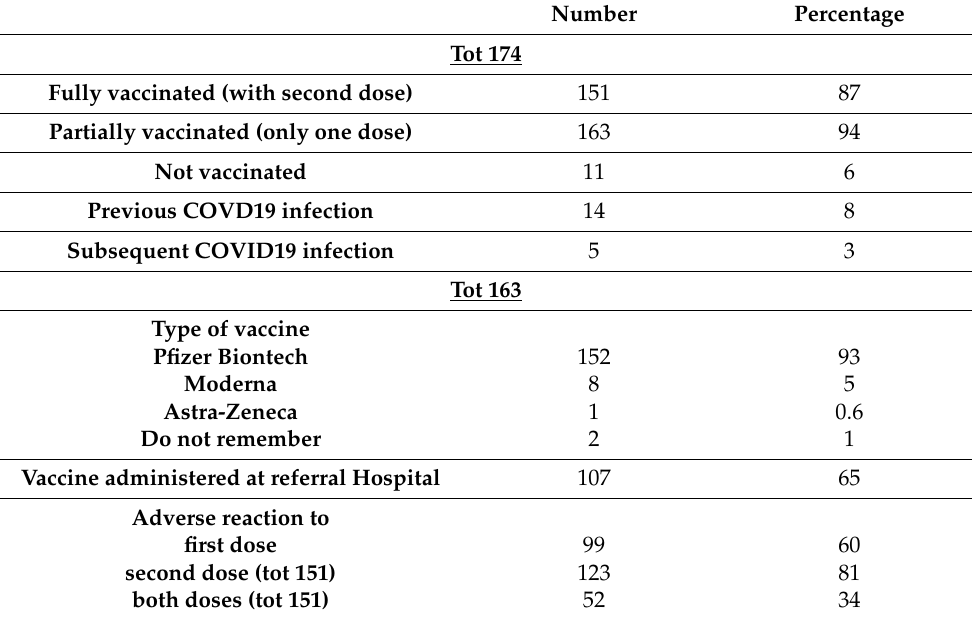
Table 2. Information on COVID-19